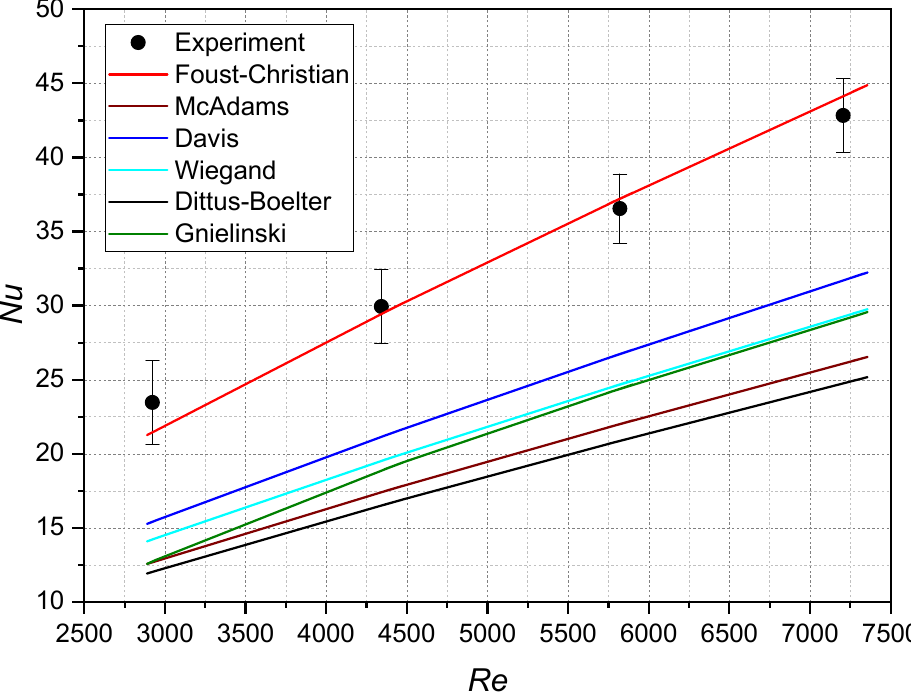
Figure 10. Experimental Nusselt ( Nu ) numbers are compared with the correlations’ values.